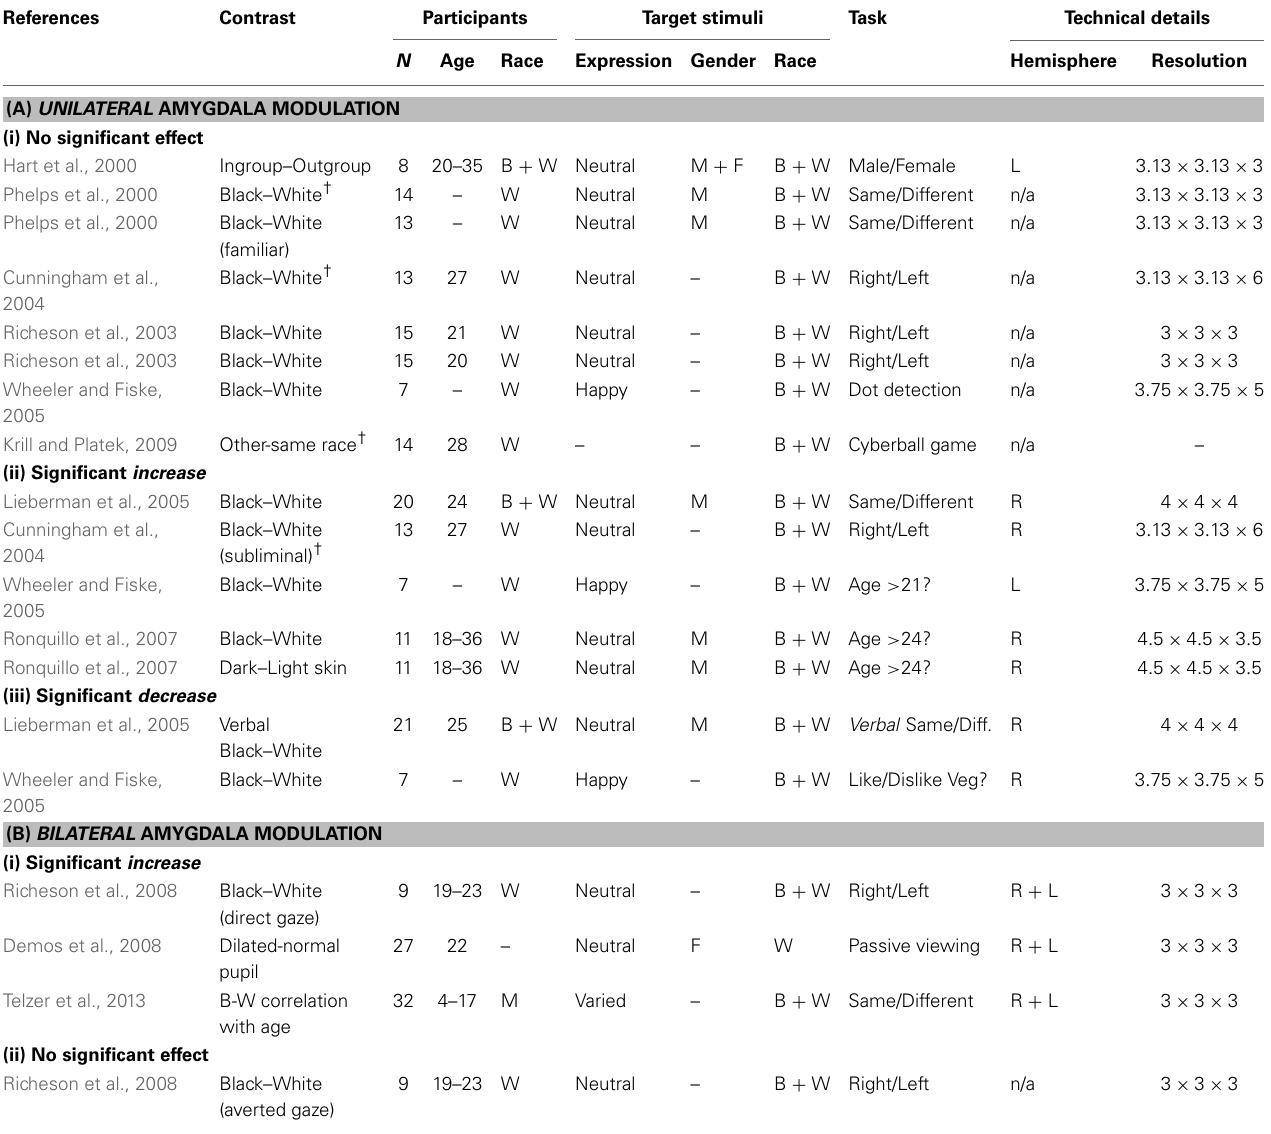
Table 1 | Reviewing amygdala activity across neuroimaging